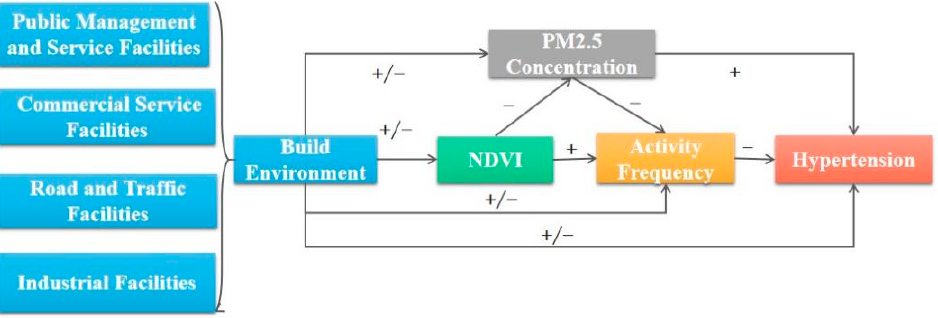
Figure 2. Conceptual diagram of serial mediation models linking built environment with hyperten- sion. Note: “+” indicates positive connection and “ − ” indicates negative